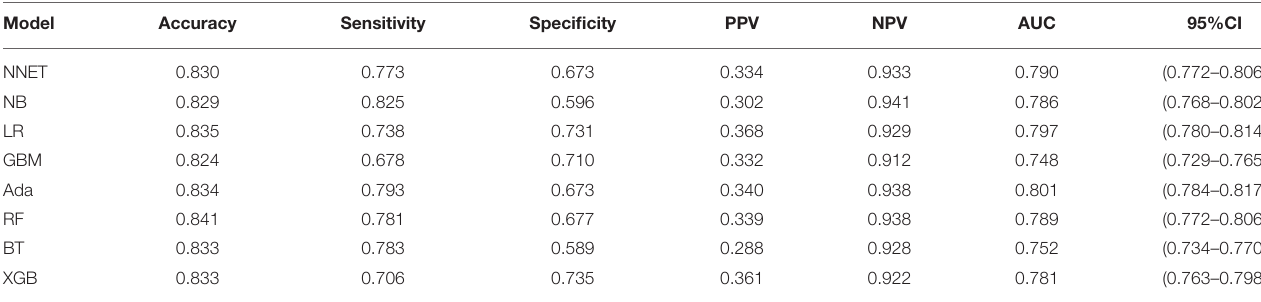
NNET, artificial neural network; NB, naïve bayes; GBM, gradient boosting machine; Ada, adapting boosting; RF, random forest; BT, bagged trees; XGB, eXtreme Gradient Boosting; LR, logistic regression; AUC, area under the curve; PPV, positive predictive values; NPV, negative predictive values, AUC, area under the curve; CI, confifidence interval.